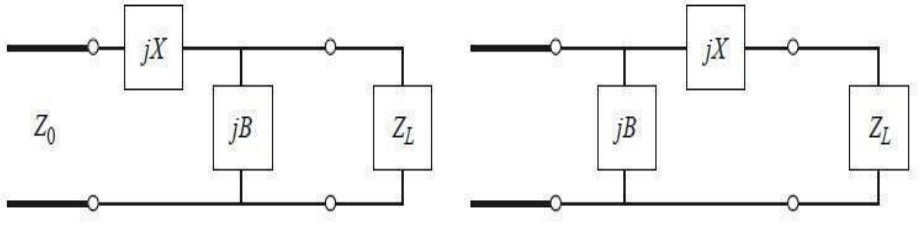
Figure 2. L-section matching